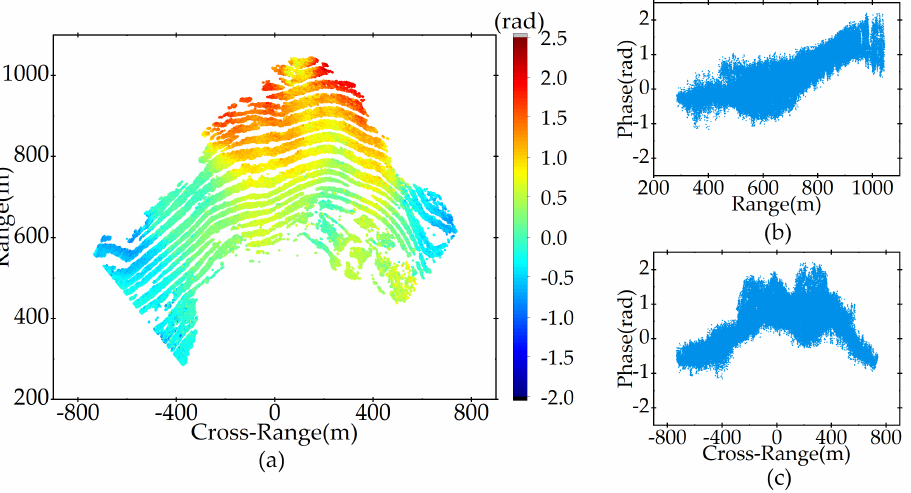
Figure 11. Original phase distribution of the 7th interferogram: ( a ) overall phase distribution, ( b ) phase distribution along the range direction, and ( c ) phase distribution along the cross-range